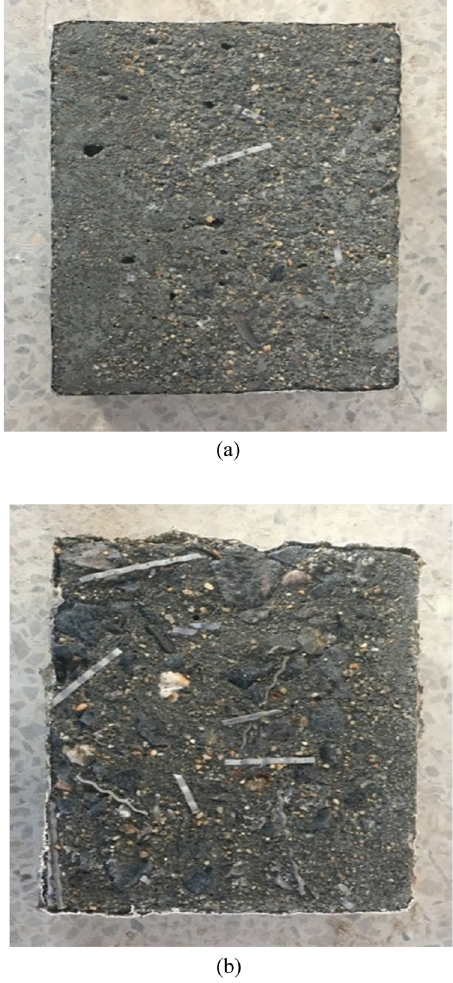
Figure 15: Surface damage of nano - concrete specimens: ( a ) spe - cimen with 1.5% SF and ( b ) specimen with 2.5%